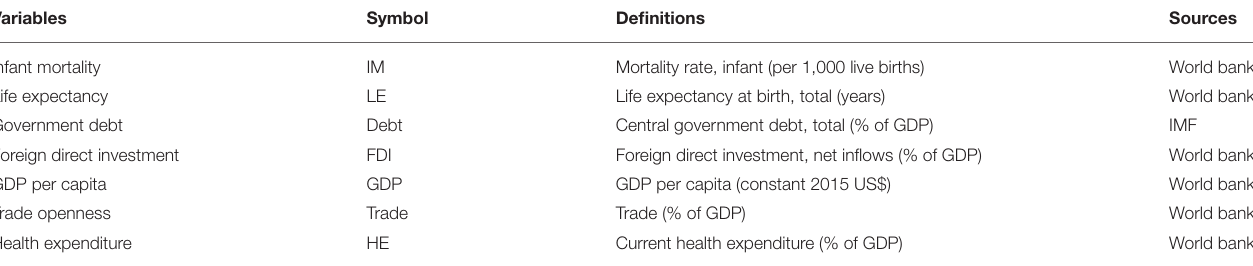
TABLE 1 | Definitions and sources.